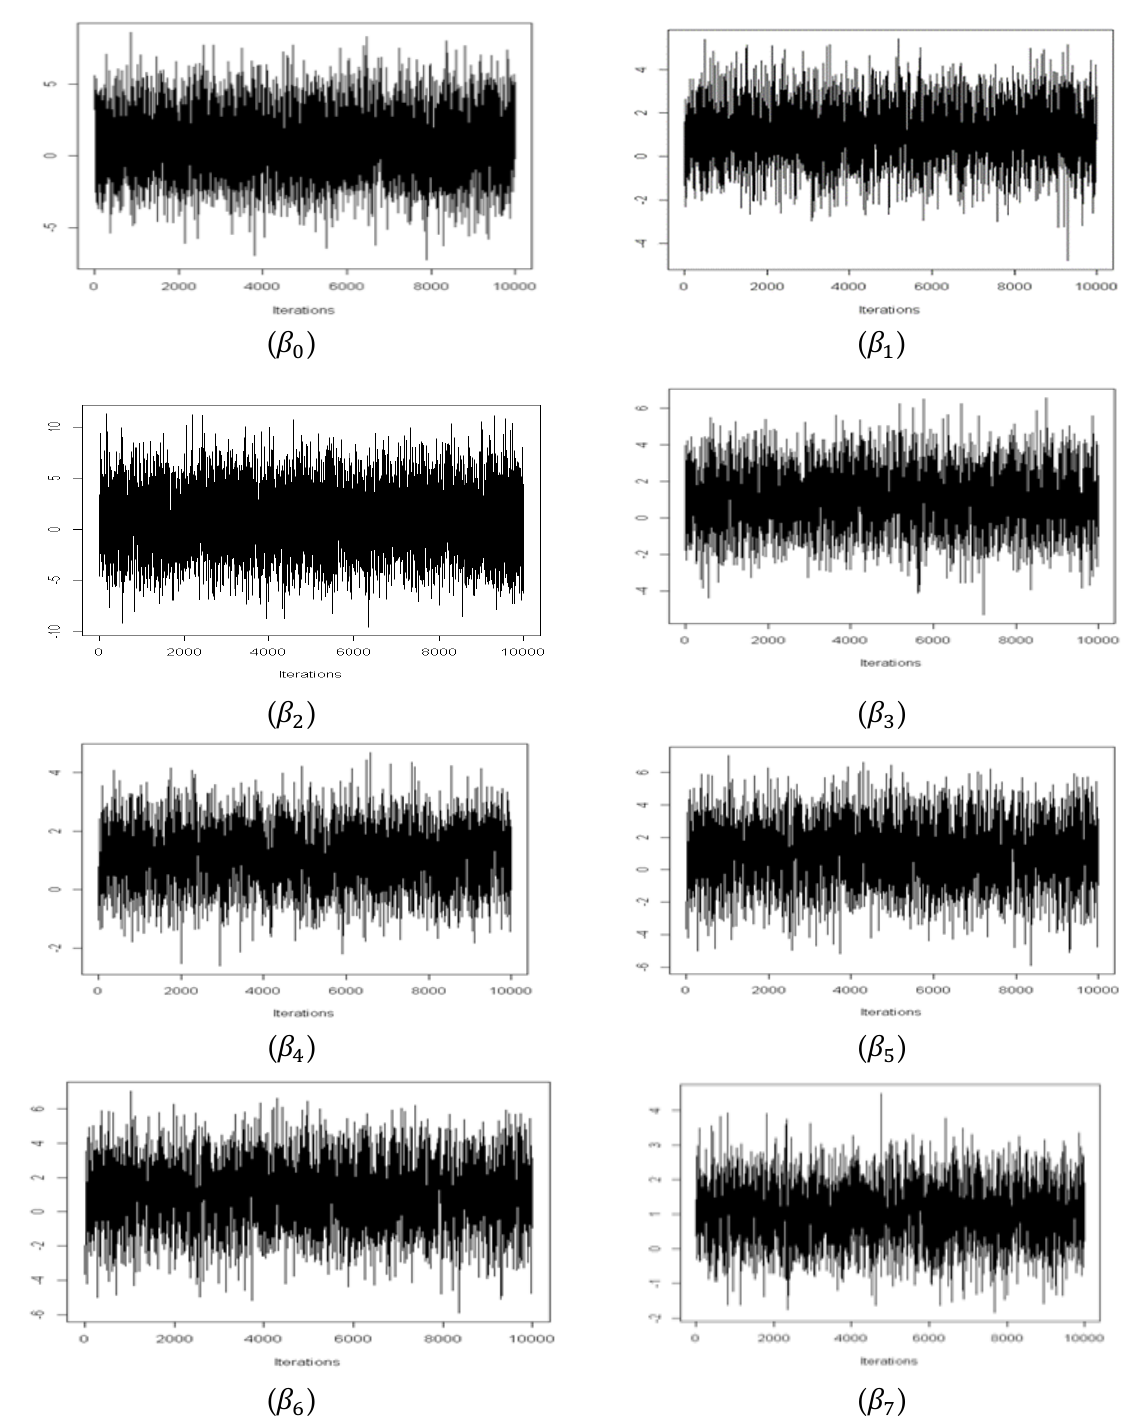
Figure 2. Trace plots of (cid:2010)